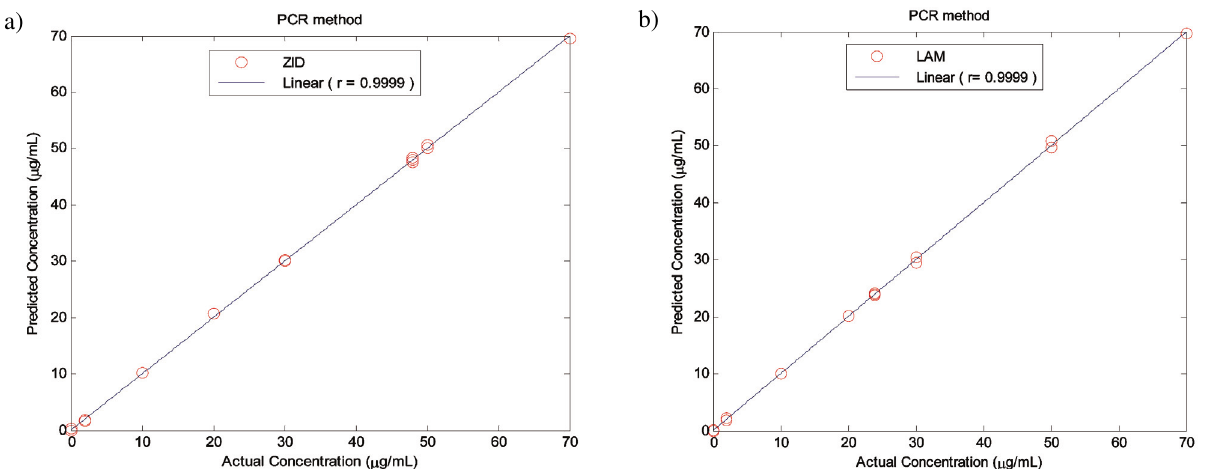
Figure 4. Plot of the actual and predicted concentrations in the calibration step by using the PCR method with four components for ZID (a) and LAM (b)